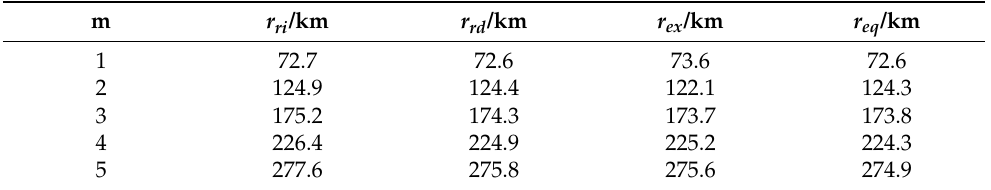
Table 3. Positions of convergence zones obtained using proposed formulation and coupled normal mode on experimental data.